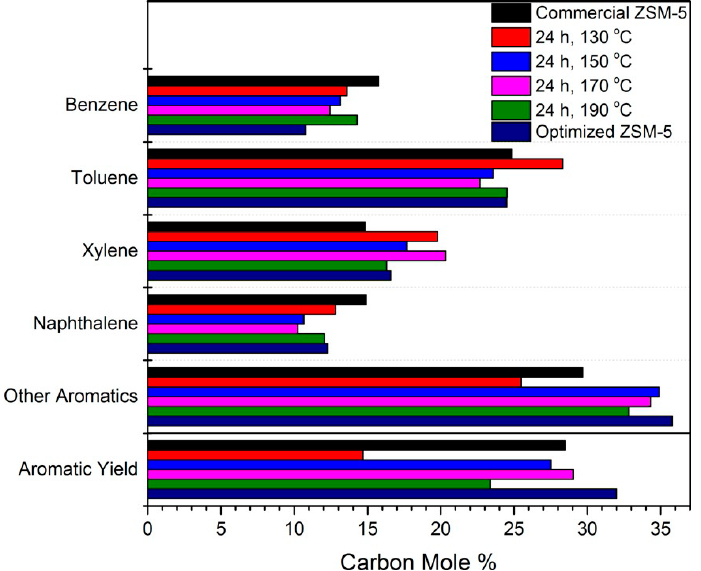
Figure 6. The selectivity and aromatic yield for the catalytic fast pyrolysis of cellulose at 700 °C. (Adapted from [126]. Copyright 2016 Wiley-VCH).